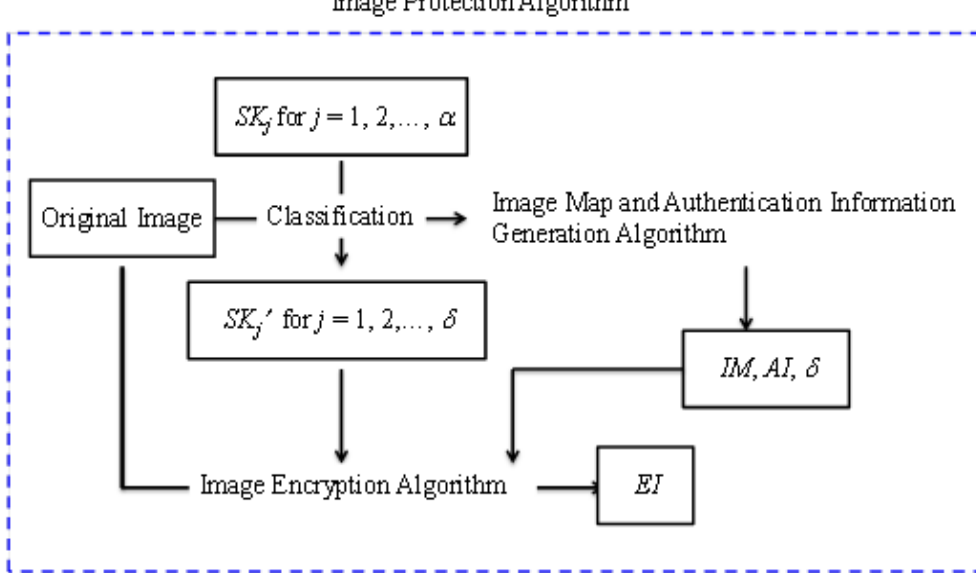
Figure 2. Flowchart of Image Protection Algorithm (Algorithm 2).